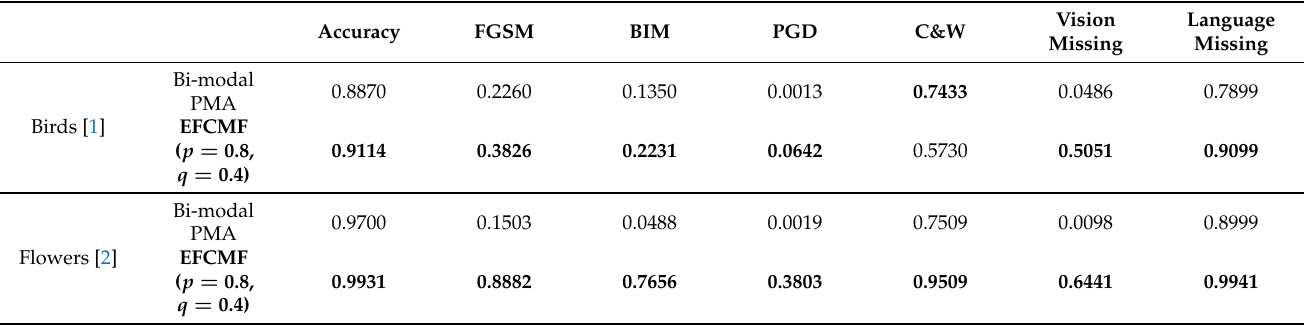
Table 3. The model’s accuracy in the face of adversarial example attacks and modalities is missing.